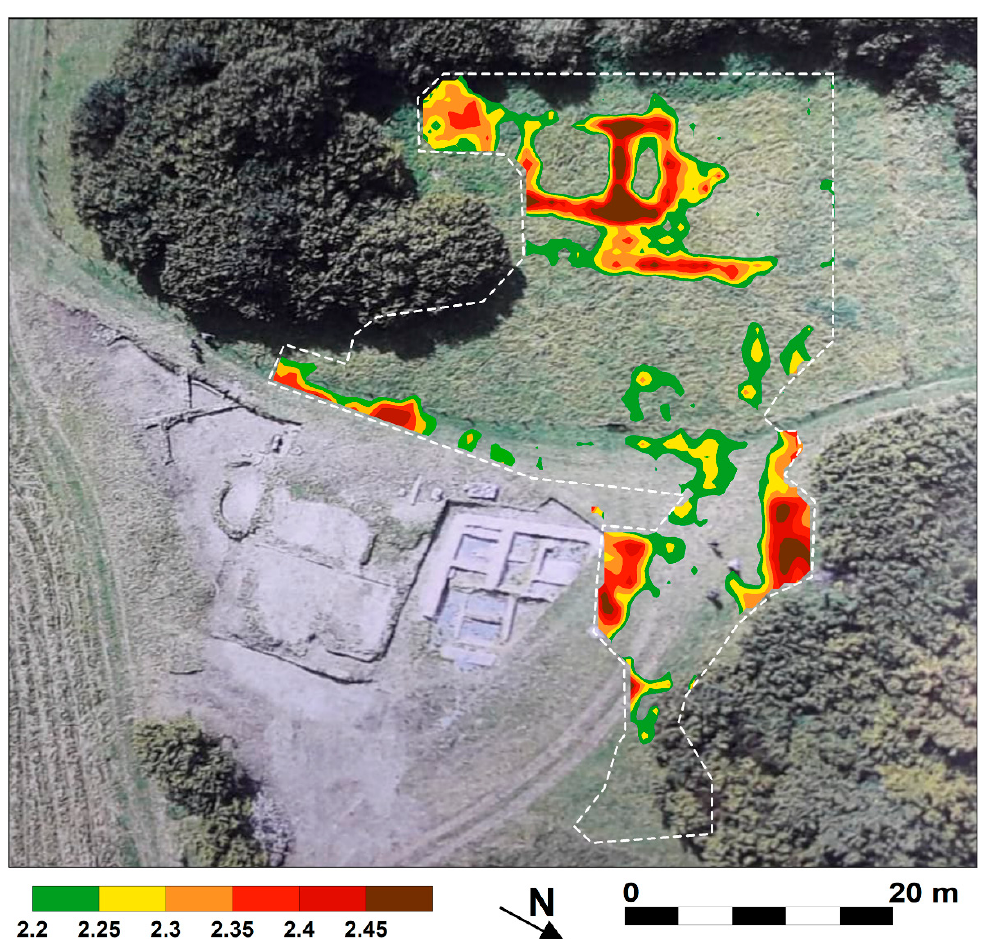
Figure 14. Municipium S: detail of the electrical resistivity map relative to D area on an image acquired by drone.